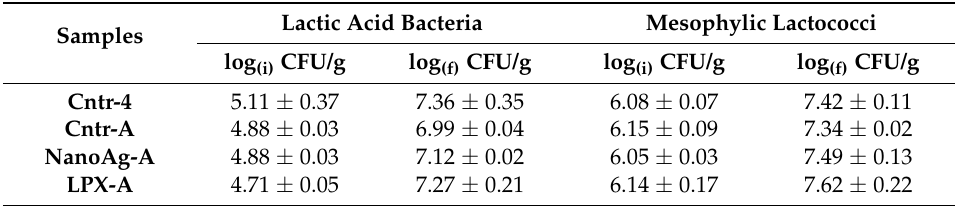
Table 4. Initial and final cell loads (log CFU/g ± sd) of lactic bacteria in Step 4. Samples